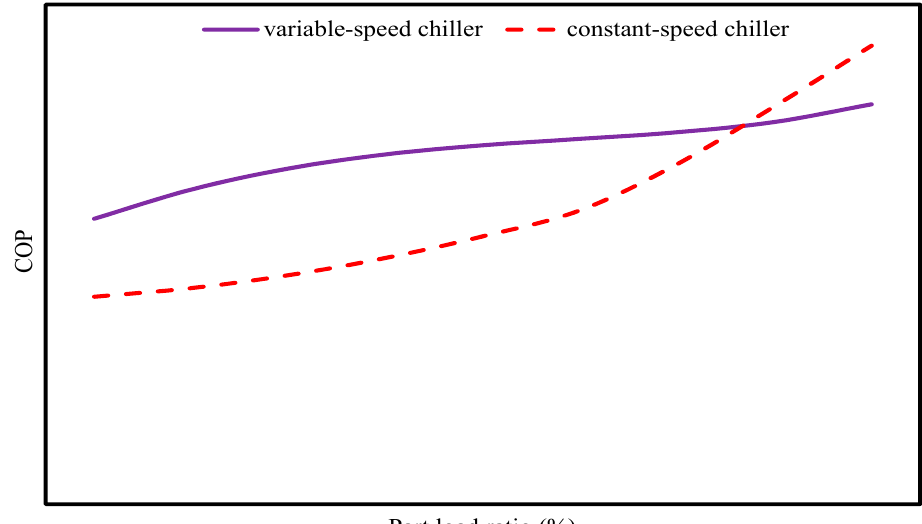
Figure 1. Coefficient of performance (COP) of a constant-speed chiller and a variable-speed